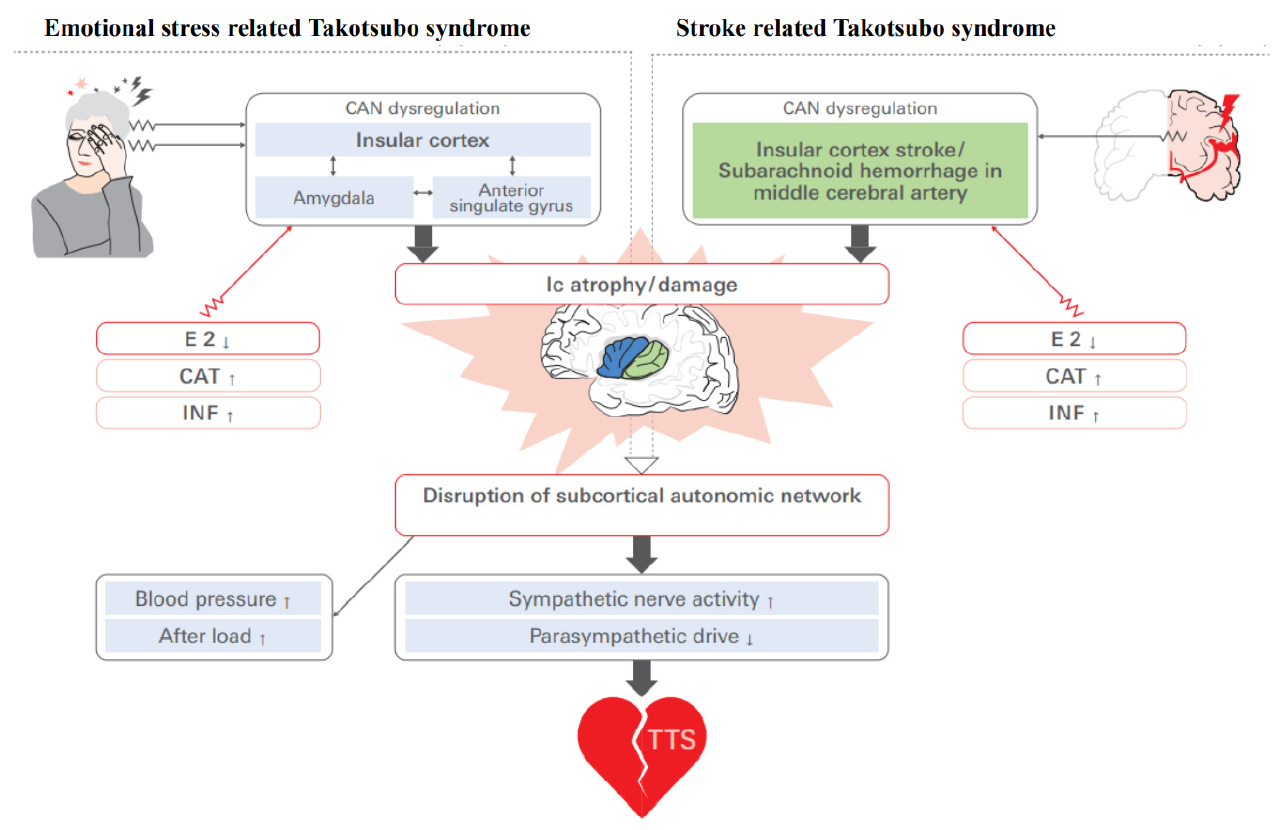
Figure 9. Possible pathways involving the Ic in the development of TTS in relation to emotional stressors and stroke. CAN: central autonomic network, E2: estradiol, CAT: catecholamine, INF: inflammatory cytokines.